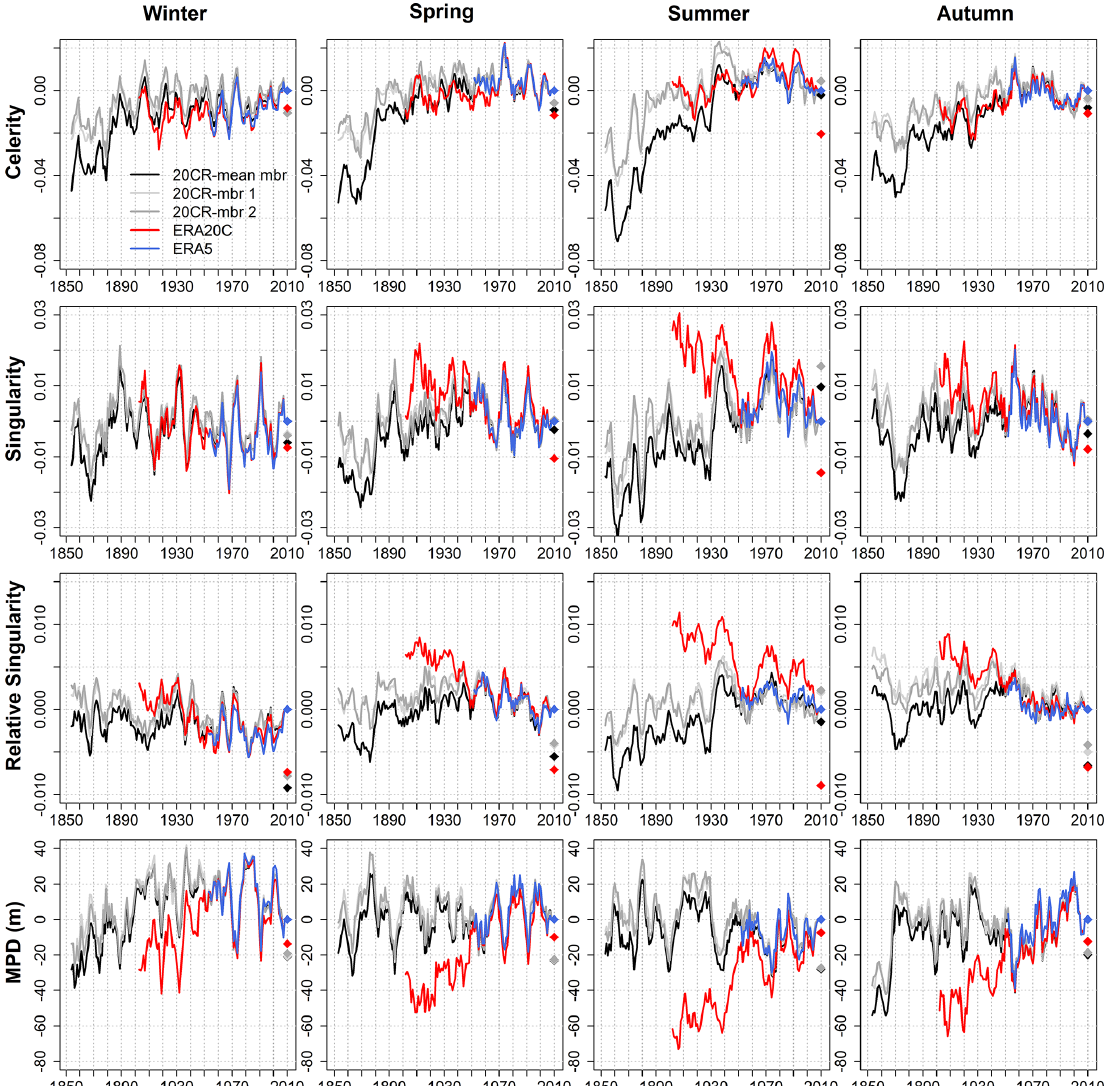
Figure 5. Evolution of the celerity, singularity, relative singularity and MPD per season over the period 1851–2010 for different reanalyses. A running average of 5 years is applied to allow a clearer visualization. Time series are represented as anomalies according to their respective 2006–2010 average. The colored dots in 2010 indicate the differences in the 2006–2010 average between ERA5 and the other reanalyses.